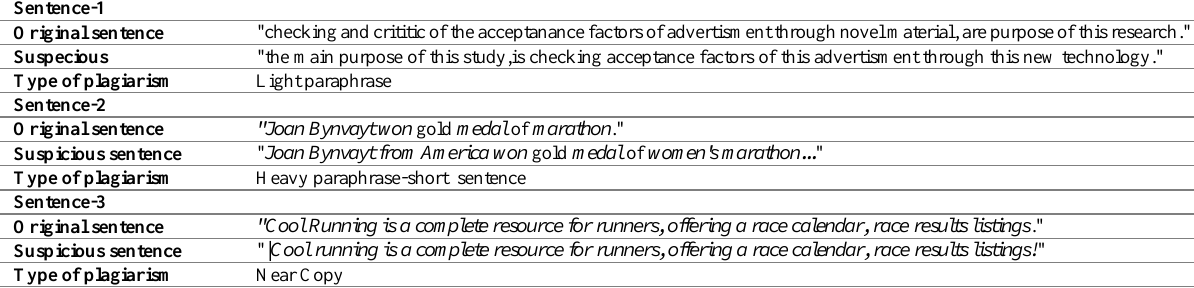
Table 3. Case study of